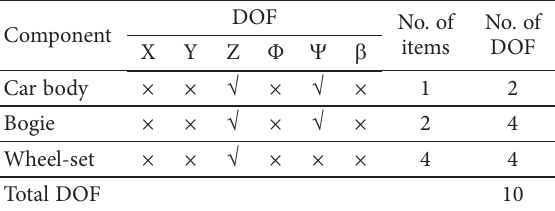
Fig. 4. Scheme for the contact forces for a wheel–rail system